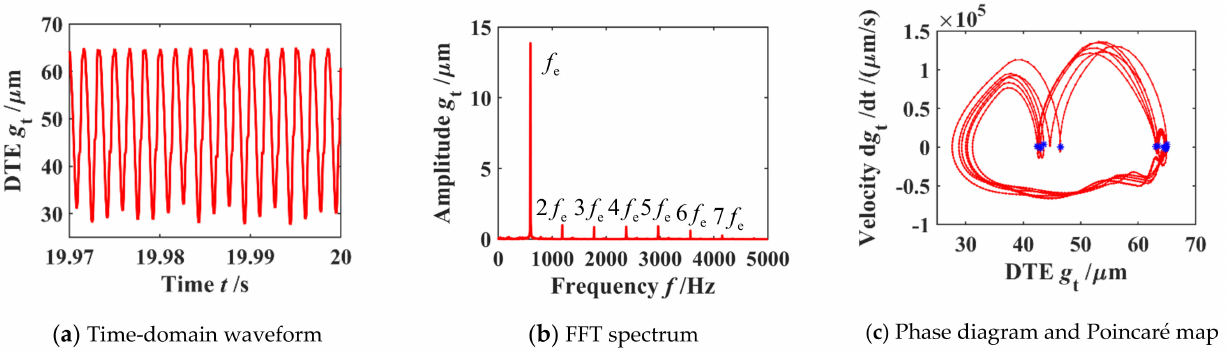
Figure 18. Dynamic responses at n 1 = 1780 rpm.